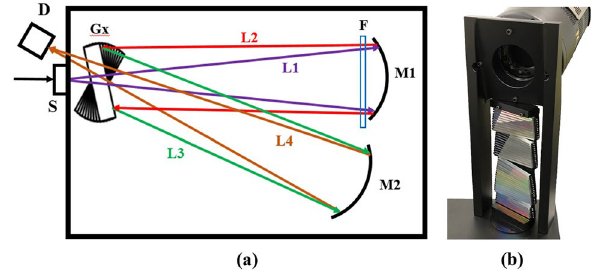
Figure 5. Schematic illustration of the high-resolution coma-free spectrometer. ( a ) The system configuration. S indicates a light beam slit, and Gx is the integrated module composed by 44 sub-gratings. The incident light enters along path L1 through a hole centered between gratings 22 and 23. The light along path L2 becomes parallel after reflected by spherical mirror M1 and then enters module Gx with an off-axis angle of α = 0. The grating-diffracted light along path L3 is then focused at the 2D focal plane of the CCD detector along path L4 after reflected by toroidal mirror M2 with an off-axis angle of β = 0. F is the set of filters applied to cut off the high order ( m ≥ 2) of the diffracted light effectively in each sub-spectral range. ( b ) The camera with the 2D BSI-CCD array detector was placed on top of the grating module with a small off-axis tilt of approximately 6° in the direction perpendicular to the diffraction plane without the coma effect [The image of ( b ) was taken by the camera of iPhone-x with the background removed by the software of Pro_KnockOut_v3.2 (www.godim age.